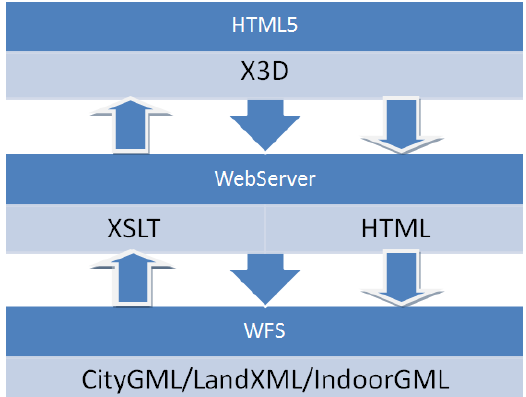
Figure 11. Transactions of geographical and alphanumeric data